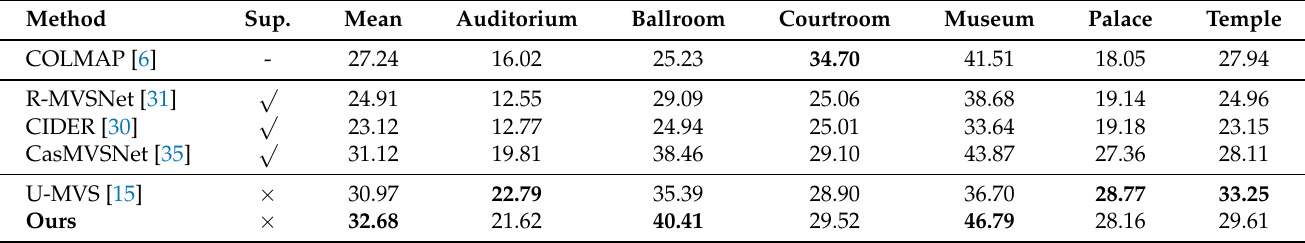
Table 4. The performance of our approach on the Tanks and Temples benchmark (advanced set) with F score (%) (higher is better). The best results are in bold. Method